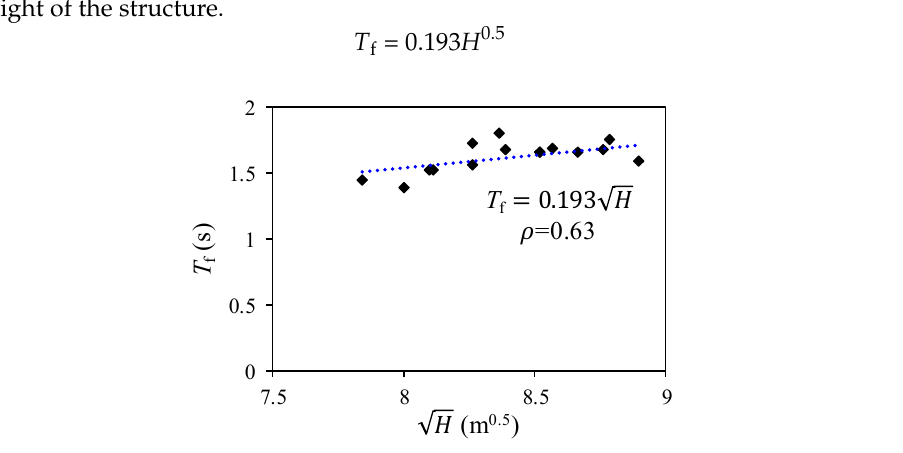
Figure 9. Relationship between the height and fundamental period of fixed ‐ base structure.